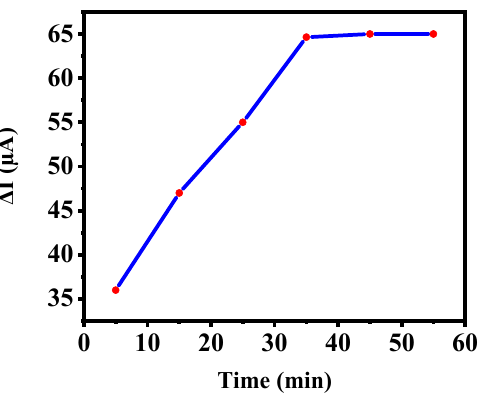
Figure 3. Time profile of aptamer/nanobiosensor interaction based on SWV techniques at different incubation times.